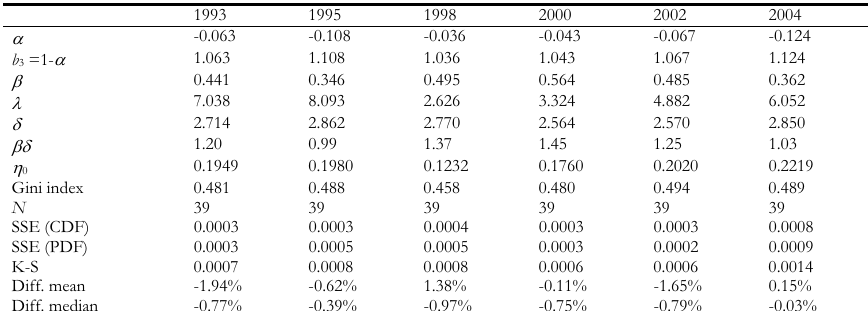
Dagum 4 parameter model estimates and summary statistics for Italian households human capital distribution from 1993 to 2004